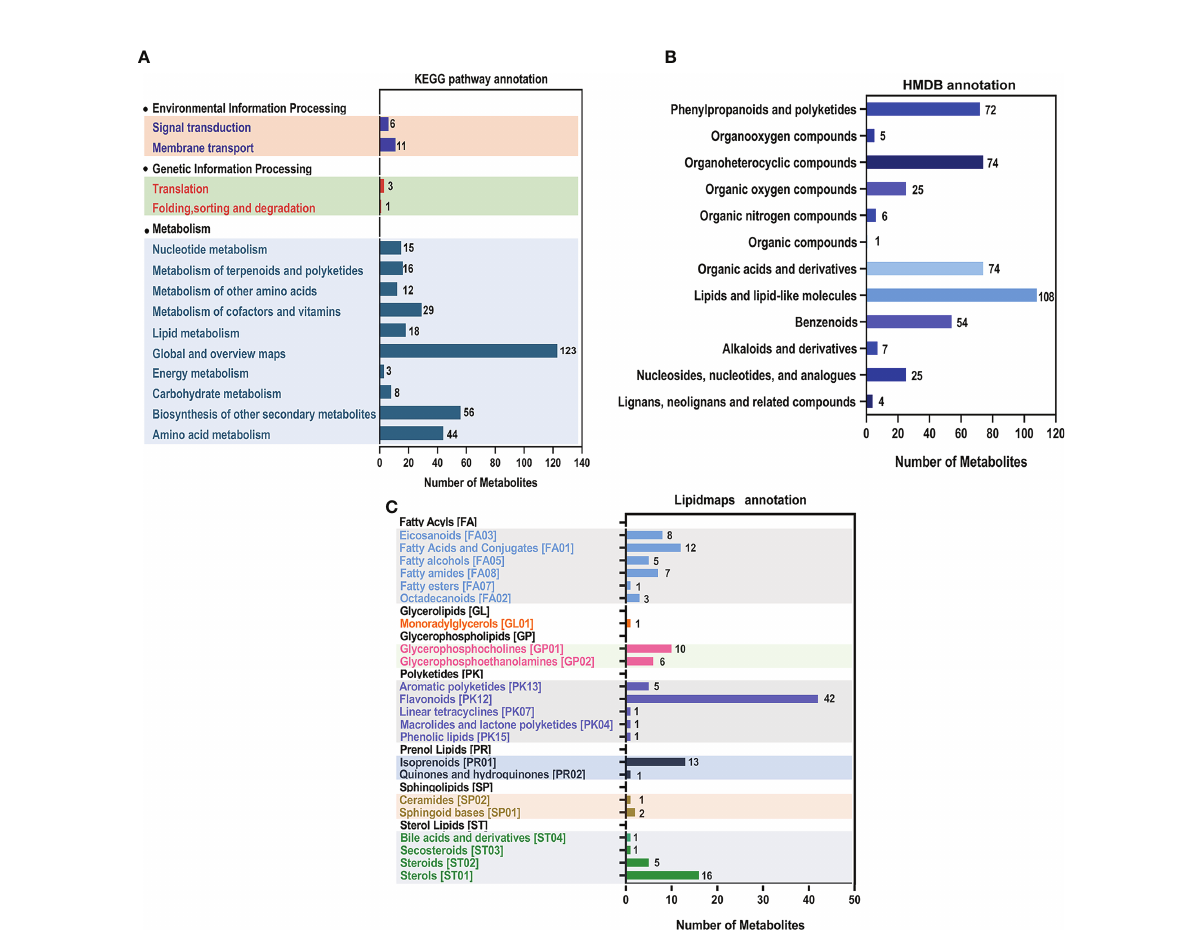
FIGURE 4 Annotation of metabolites using the KEGG pathway, HMDB categories, and LIPID MAPS. The horizontal coordinates represent the number of metabolites in all three fi gures. (A) The vertical axis represents the annotated KEGG pathways, and the graph shows the number of metabolites annotated in each secondary classi fi cation under the pathway primary classi fi cation. (B) The vertical axis represents the annotated HMDB categories, and the graph shows the number of metabolites annotated to the secondary categories (Super Class) in the HMDB. (C) The vertical coordinate represents the annotated LIPID MAPS lipid categories, and the graph shows the number of (lipid) metabolites annotated to the main hierarchical category (Main_Class) under the seven major lipid categories (Categories) in LIPID